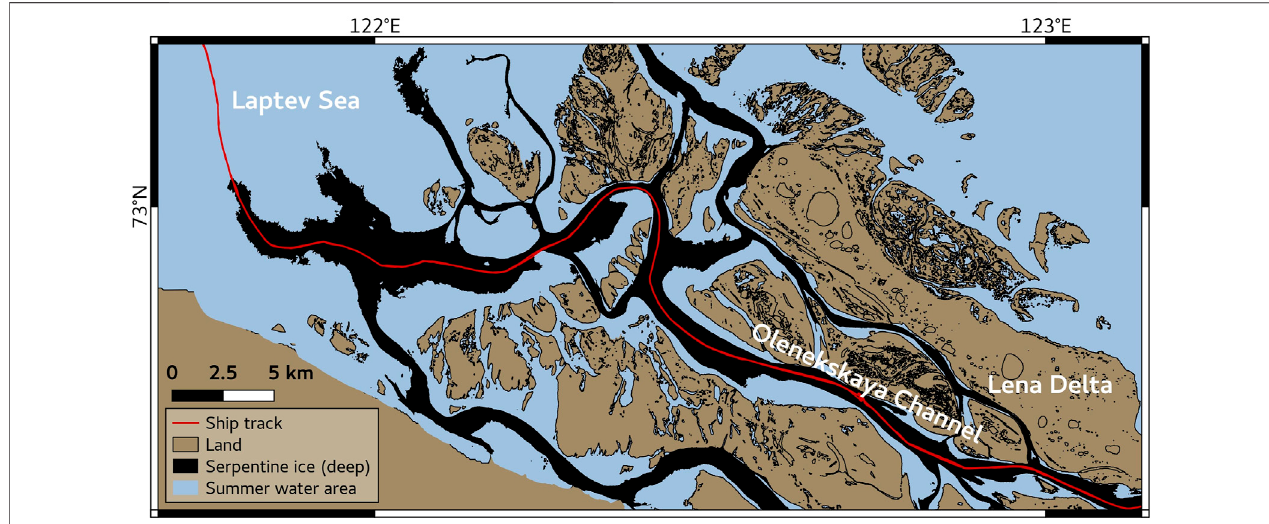
Frontiers in Earth Science |